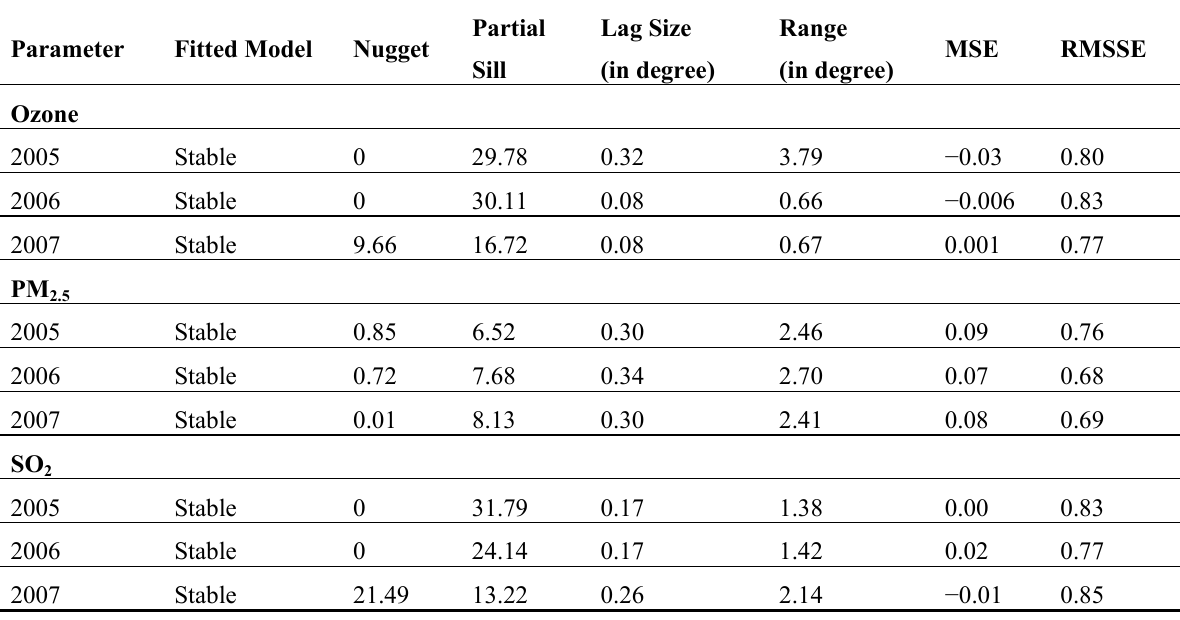
Table 2. Parameters of semivariogram model.